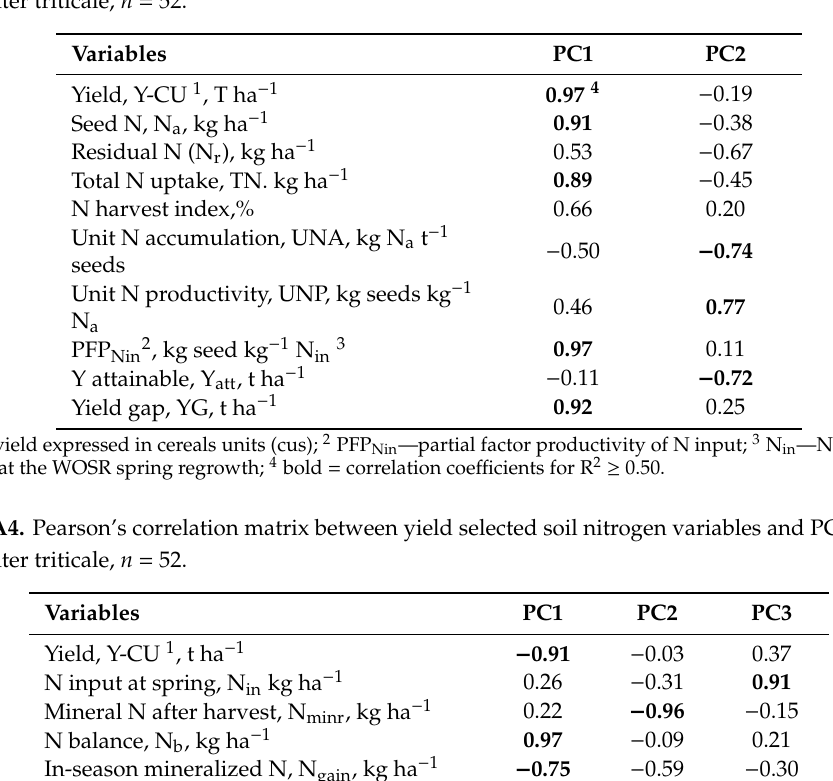
Table A3. Pearson’s correlation matrix between yield selected plant nitrogen variables and PCA factors for winter triticale, n = 52.